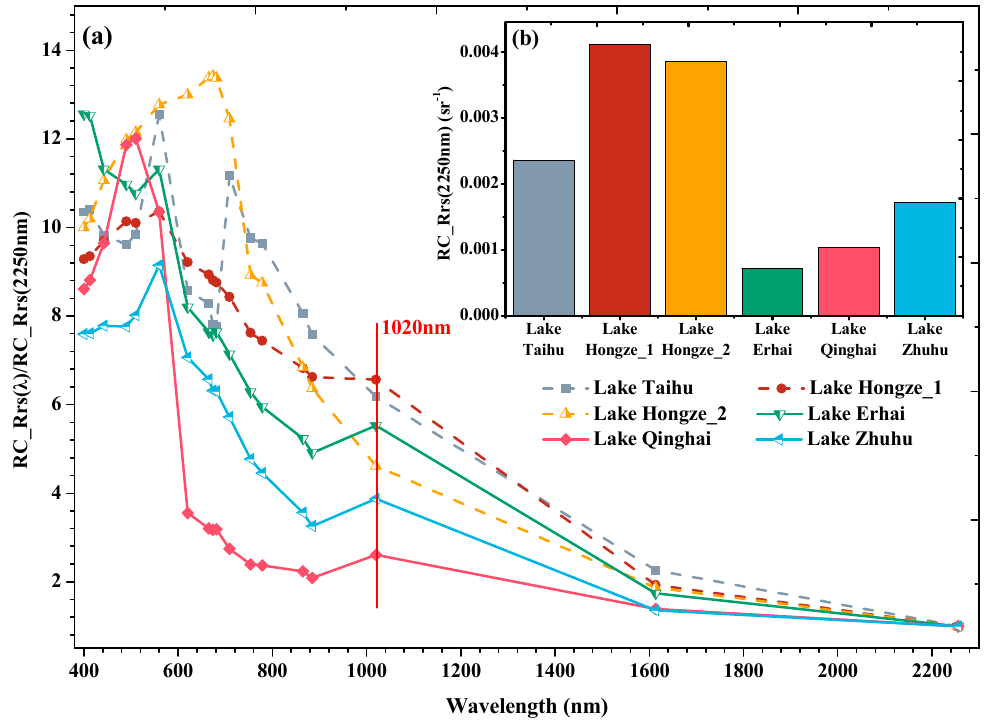
Figure 11. Six typical spectral curves from the different water bodies. ( a ) Lake Hongze_1 and Lake Hongze_2 represent the pixels near the shore and away from the shore, respectively. The spectral curves of Lake Erhai, Lake Taihu, Lake Qinghai, and Lake Zhuhu are located in the corresponding lakes. To eliminate differences in magnitude between different turbid conditions, all spectral curves were normalized based on R rs (2250) with their distributions displayed in the histogram ( b ).